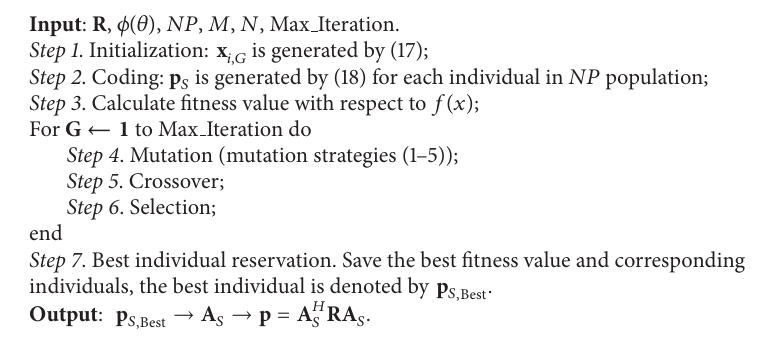
Algorithm 1: Sparse antenna array design using DE algorithm with